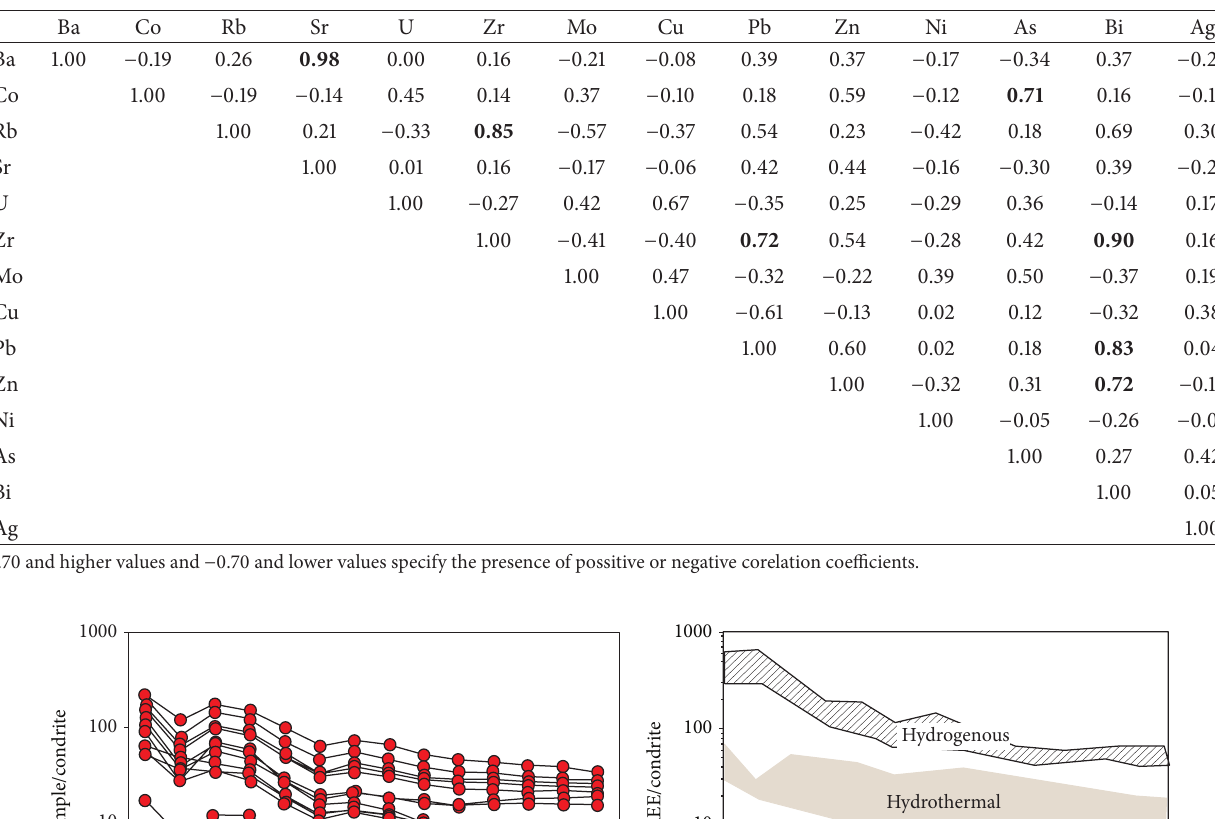
Table 6: Correlation relations for trace elements.